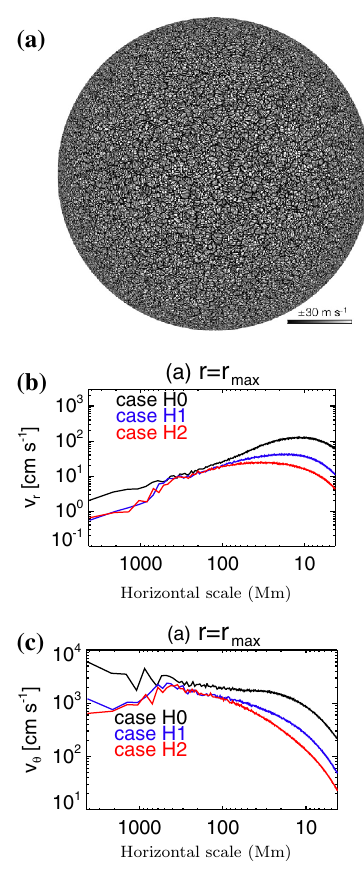
Fig. 11 a Radial velocity, b radial (vertical) velocity spectrum and c latitudinal (horizontal) velocity spectrum at r / R (cid:3) = 0 . 99 (case H0 in black) in global simulations (Hotta et al. 2014) (cases H1 and H2 only extend up to r / R (cid:3) = 0 . 96 and have smaller density contrasts). The qualitative behaviour of both spectra is very similar to the surface radial and spheroidal spectra derived from observations by Rincon et al. (2017) (black and blue in Fig.